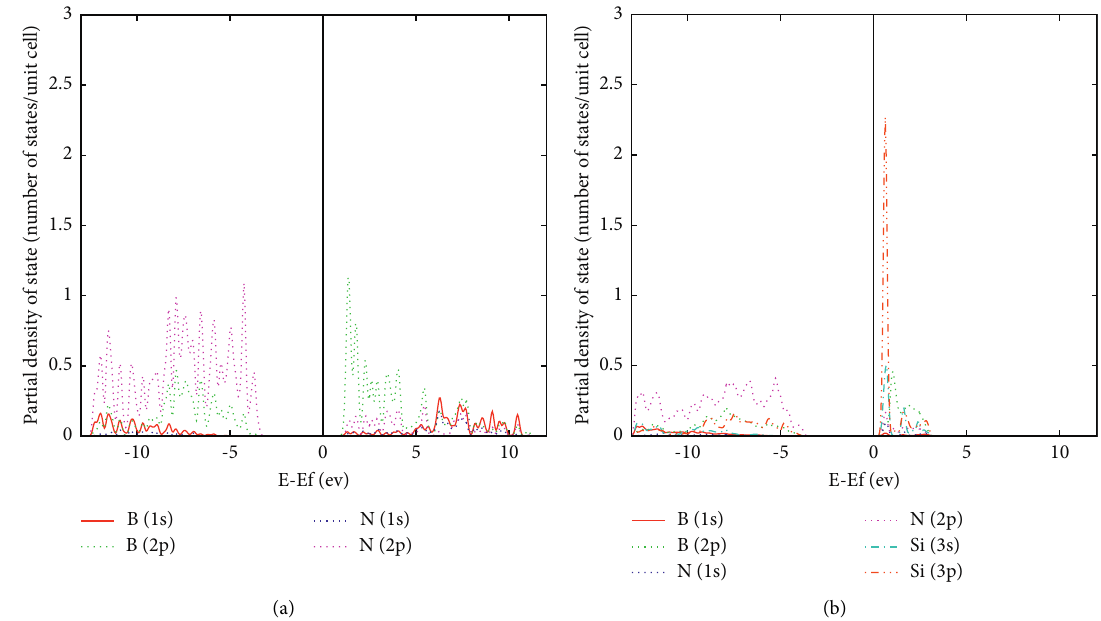
Figure 3: The calculated partial density of state (PDOS). (a) Pure monolayer BN. (b) Single Si-doped monolayer BN. The zero-energy represents the Fermi